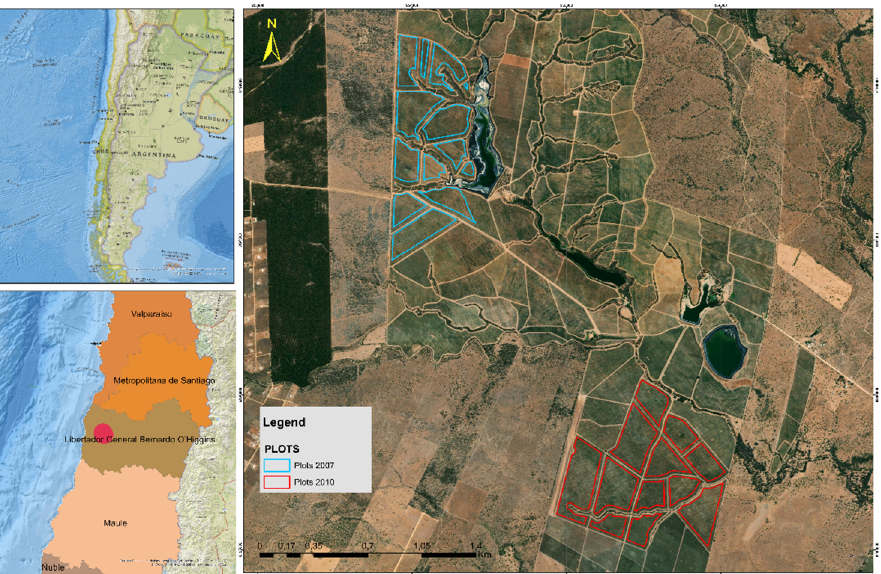
Figure 1. Maps of the general location ( left ) and the location of the Cabernet Sauvignon plots ( right ); cyan polygons correspond to 2007 plantations and red polygons to 2010 plantations. Background Image: BaseMap ArcGIS, World Imagery.